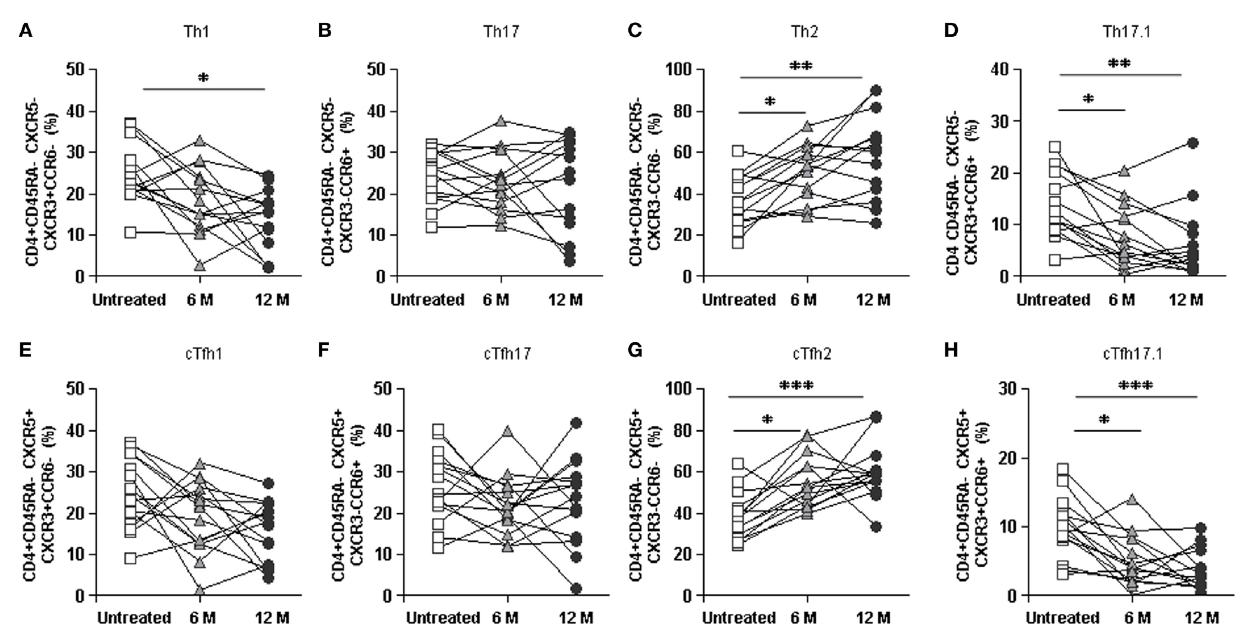
FigUre 6 | Longitudinal study of the effect of dimethyl fumarate on Th and cTfh subpopulations from multiple sclerosis (MS) patients. (a–D) Percentages of Th1, Th17, Th2, and Th17.1 non-follicular T cells and (e–h) cTfh1, cTfh17, cTfh2, and cTfh17.1 follicular T cells from MS patients, before treatment (white squares) and 6 months (6 M: light gray triangles) and 12 months (12 M: dark gray circles) after treatment. Successive repeated measures on the same individual are represented by connecting lines. Friedman paired test p -values: * p < 0.05, ** p < 0.01, and *** p <